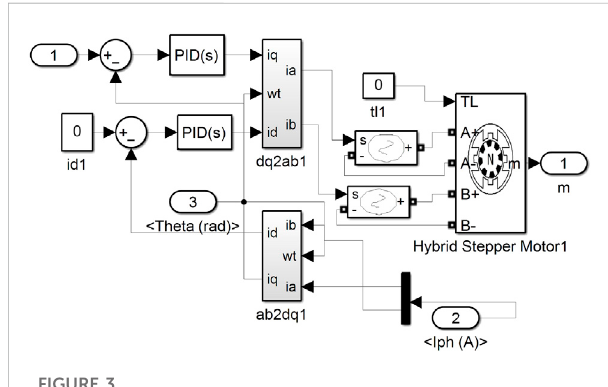
FIGURE 3 The block diagram of stepper motor control